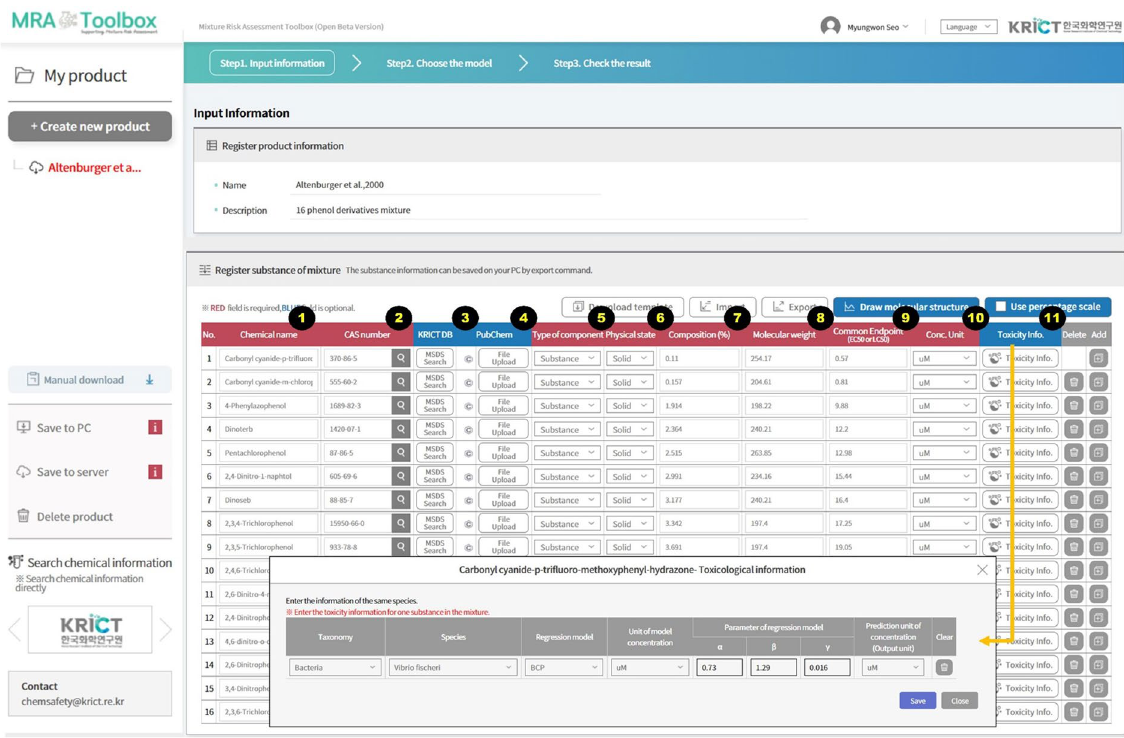
Figure 3. MRA Toolbox graphical user interface (GUI) to enter chemical product, composition, and hazard